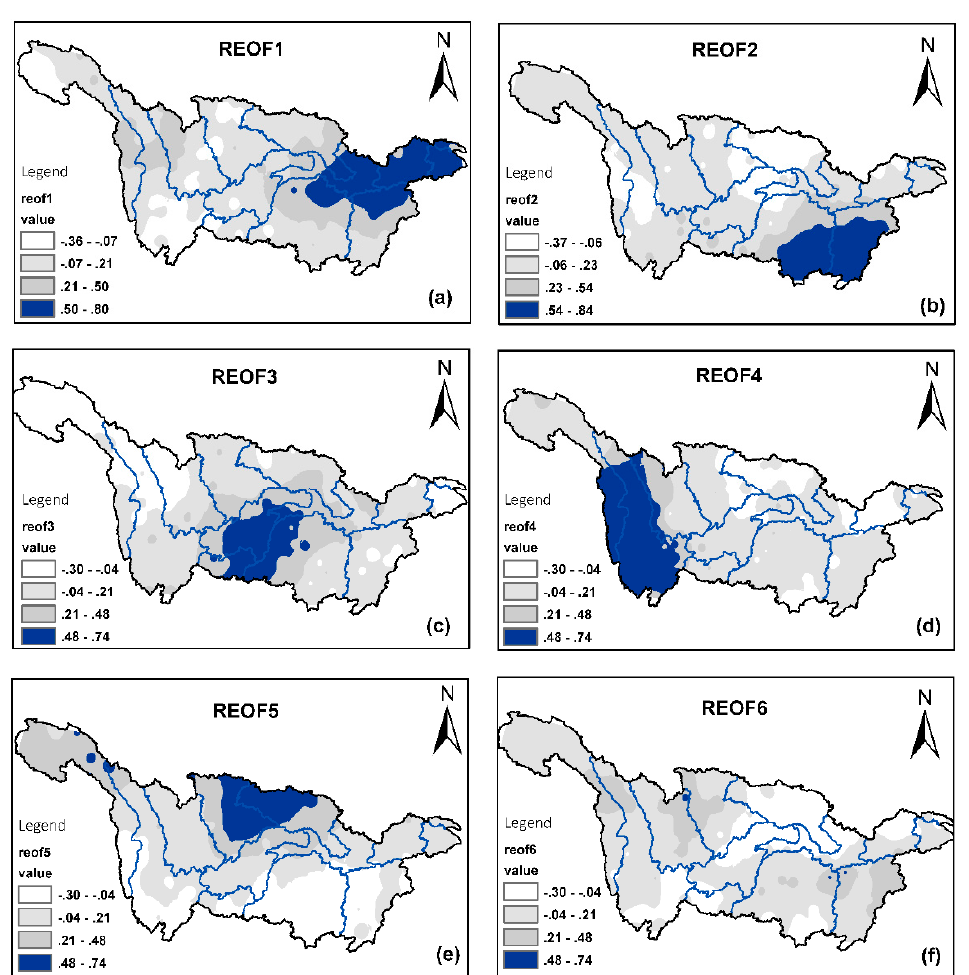
Figure 3. The REOF results of SPEI (at 12-month scale). Mode 1 ( a ), Mode 2 ( b ), Mode 3 ( c ), Mode 4 ( d ), Mode 5 ( e ) and Mode 6 ( f ) are the first six modes. The blue area represents the high loading value. The value of the load is divided into four classes. In order to highlight the difference, the rest of the three lower values are expressed in grayscale.